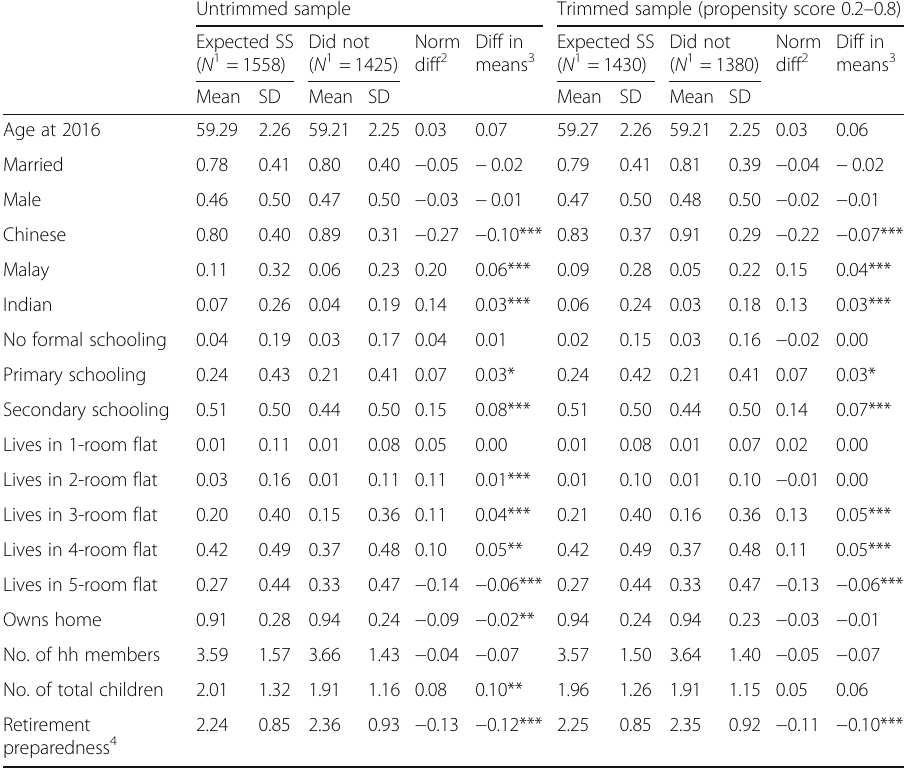
Table 30 Summary statistics for baseline demographics considered in propensity score estimation — comparison between those who expected and did not expect SSS payout, among individuals aged 56 to 63 in